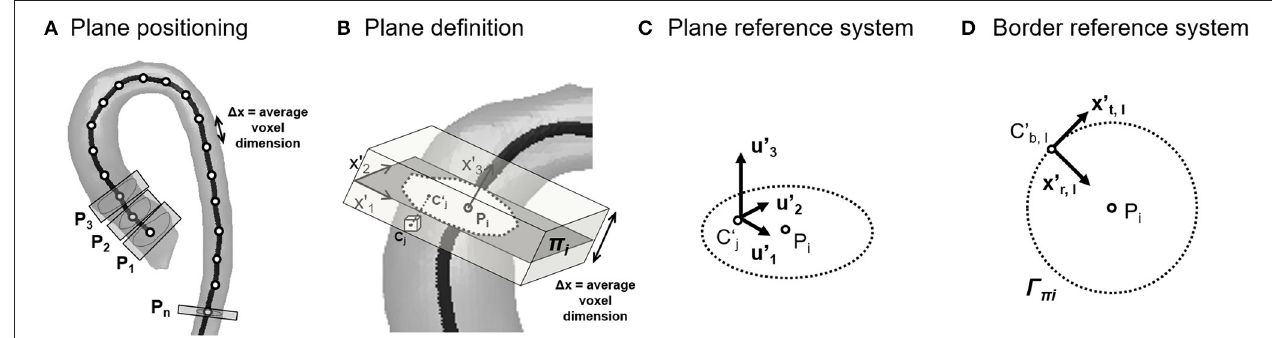
FIGURE 2 | (A) Position along the centerline of the points (P i ) used to define the cross-sections of the aortic lumen; (B) On each cross-section, original discrete velocity points (C j ) enclosed by the segmentation and within a tolerance (0.51 of a voxel) were projected as (C’ j ) on the plane ( π i ) and interpolated. According to the orientation of the cross-section, local reference systems were defined inside the vessel lumen (C) and on the vessel’s wall (D) .